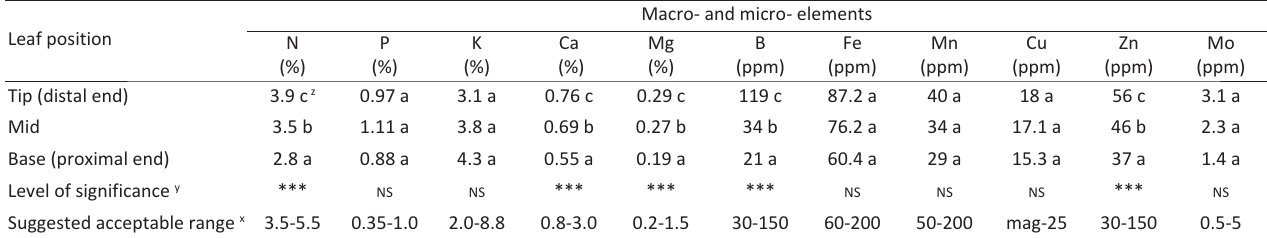
Table 2 ­ Macro­ and micro­elements of Ornithogalum dubium from the distal­, mid­ and basal portion of third leaves from the base of the scape that do not show leaf burn symptom